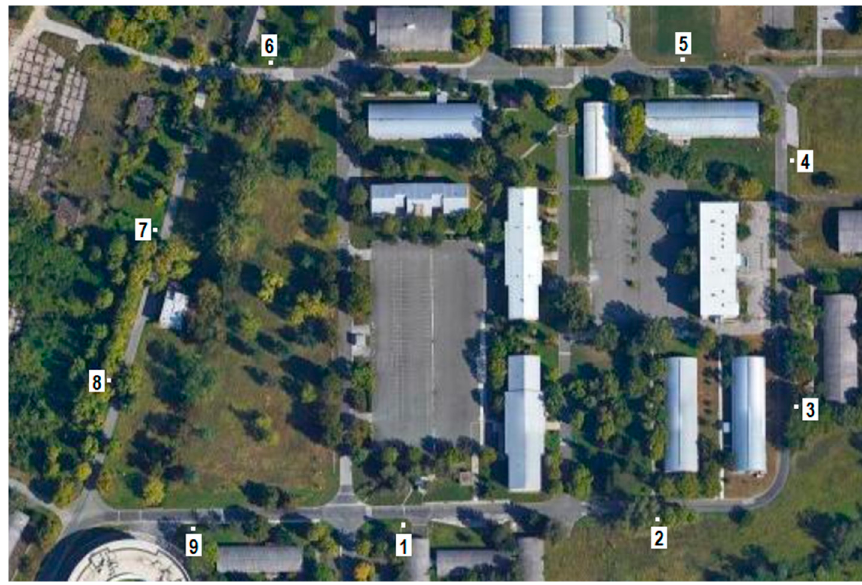
Figure 1. Layout of the test route and placement of the signs.